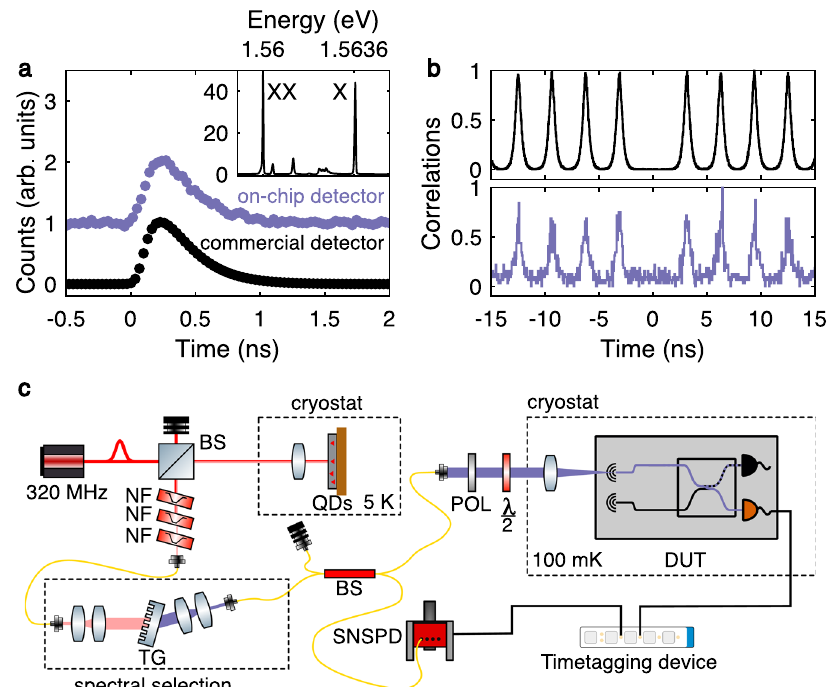
Fig. 3 Single-photon experiments. a Lifetime measurements using our device (purple) compared to commercial fi ber – coupled SNSPDs (black). Inset: spectrum of the deterministically excited quantum dot used in this work, under π pulse excitation, with highlighted exciton (X) and biexciton (XX) lines. b HBT measurements, showing a comparison of detection off-chip (top) and detection with one SNSPD on-chip (bottom). c Sketch outlining the experimental con fi guration. For a the lifetime of the QD is either fully measured on-chip or using the commercial SNSPD system. For b one arm of the HBT setup is on-chip while the second arm is connected to the SNSPD system. The coincidences are then measured using a time-to-digital converter. Optical components: BS beam splitter, NF notch fi lter, TG transmission grating, POL polarizer, ( λ ) half waveplate, DUT device under 2